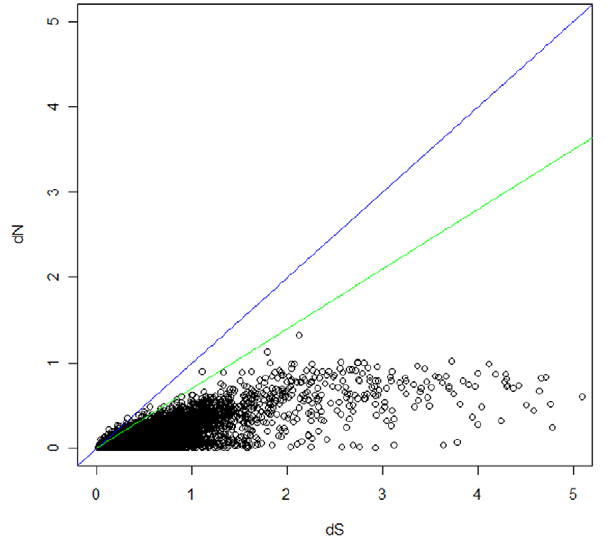
Figure 7. Substitution estimation scatter plot. We calculated the nonsynonymous mutation rate (dN) and synonymous mutation rate (dS) using orthologous genes between bat and human. Two lines were drawn representing the two dN/dS cutoffs of 0.7 (green) and 1.0 (blue).